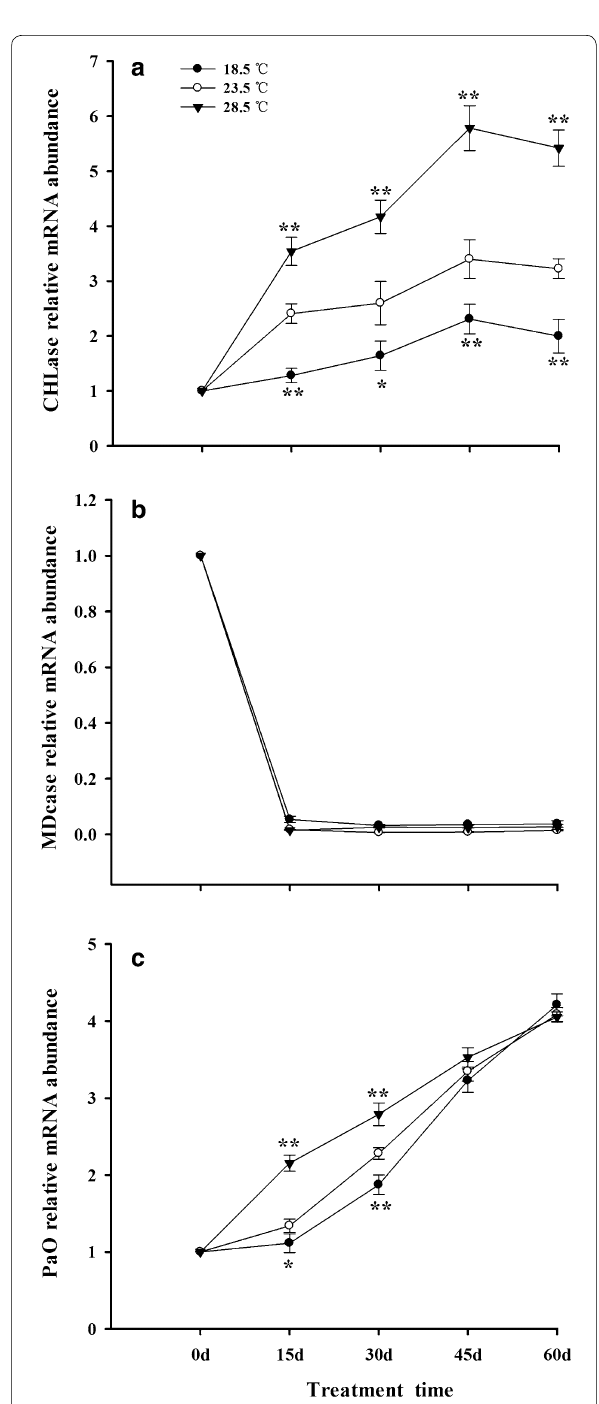
Fig. 7 Effects of different growth temperatures on expression of Chls degradation related-genes in tobacco leaves. CHLase ( a ); MDcase ( b ); and PaO ( c ),